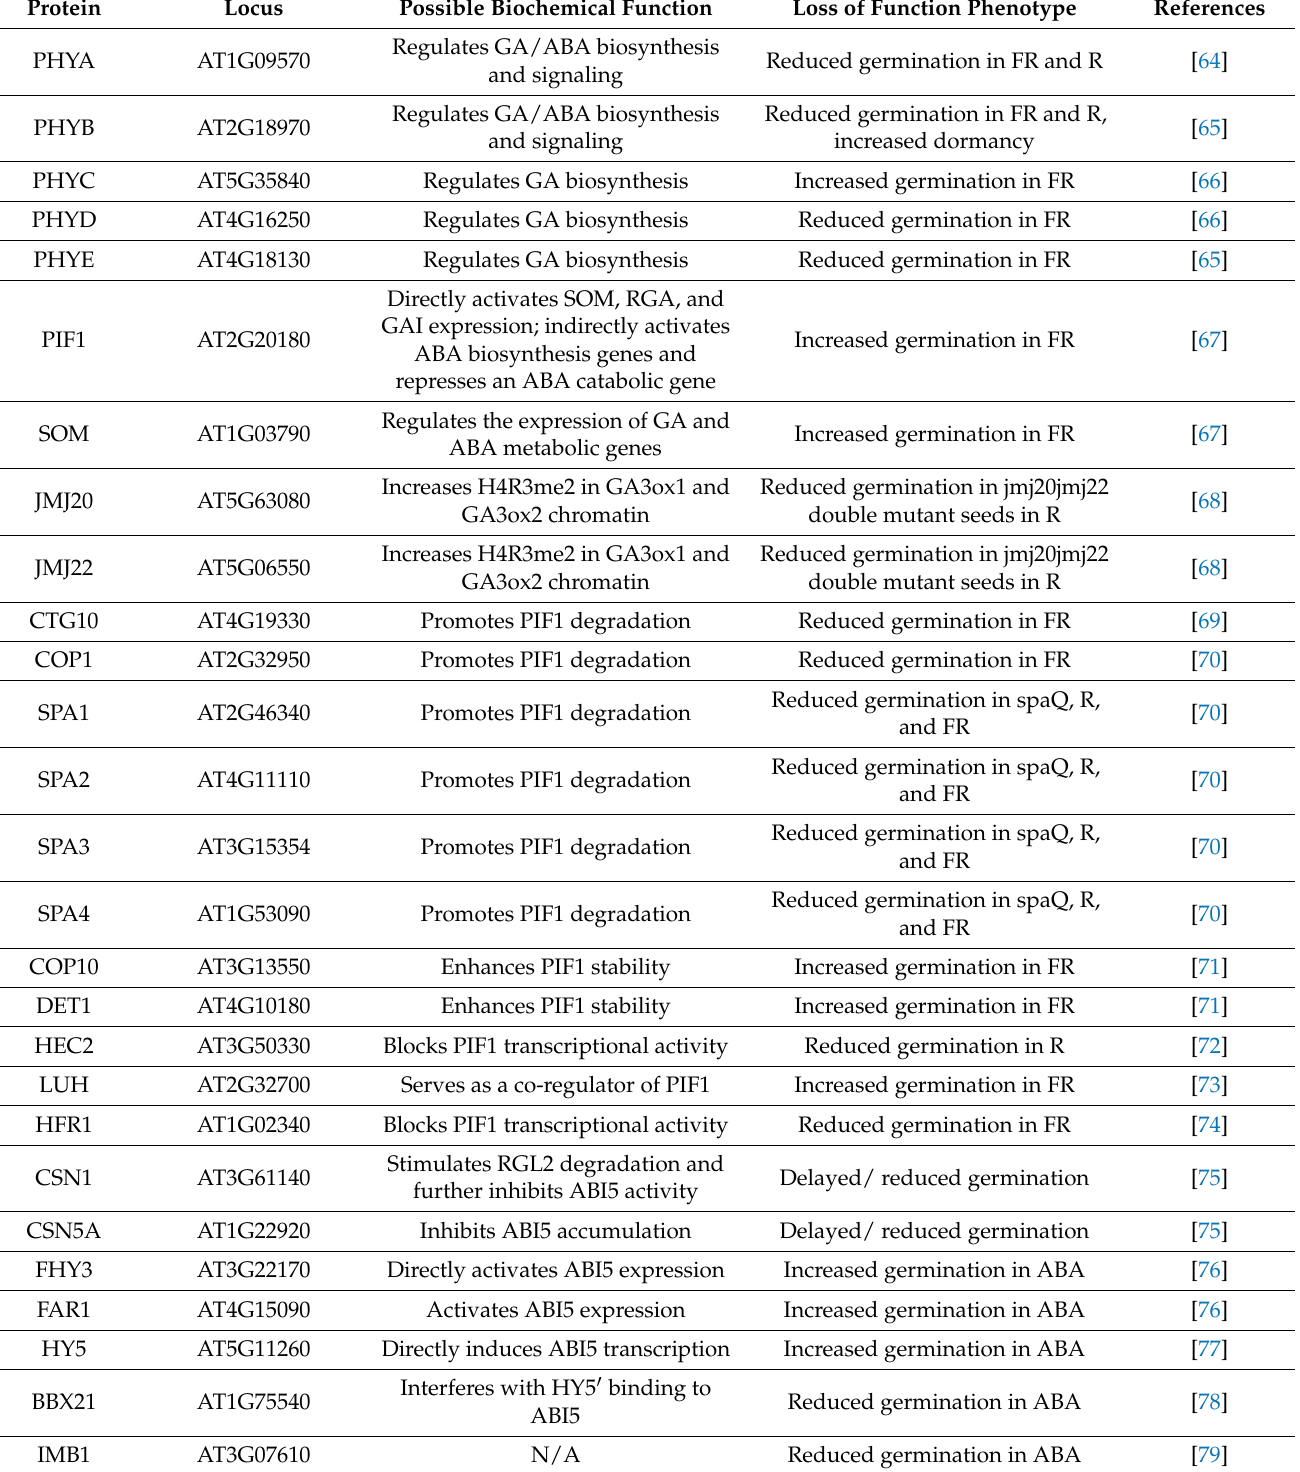
Table 2. The factors involved in the light regulation of seed dormancy and